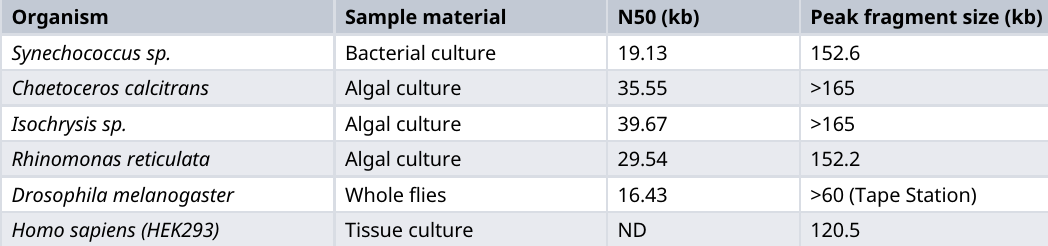
Table 1. Representative Nanopore MinION N50 raw-reads and fragment length analysis.